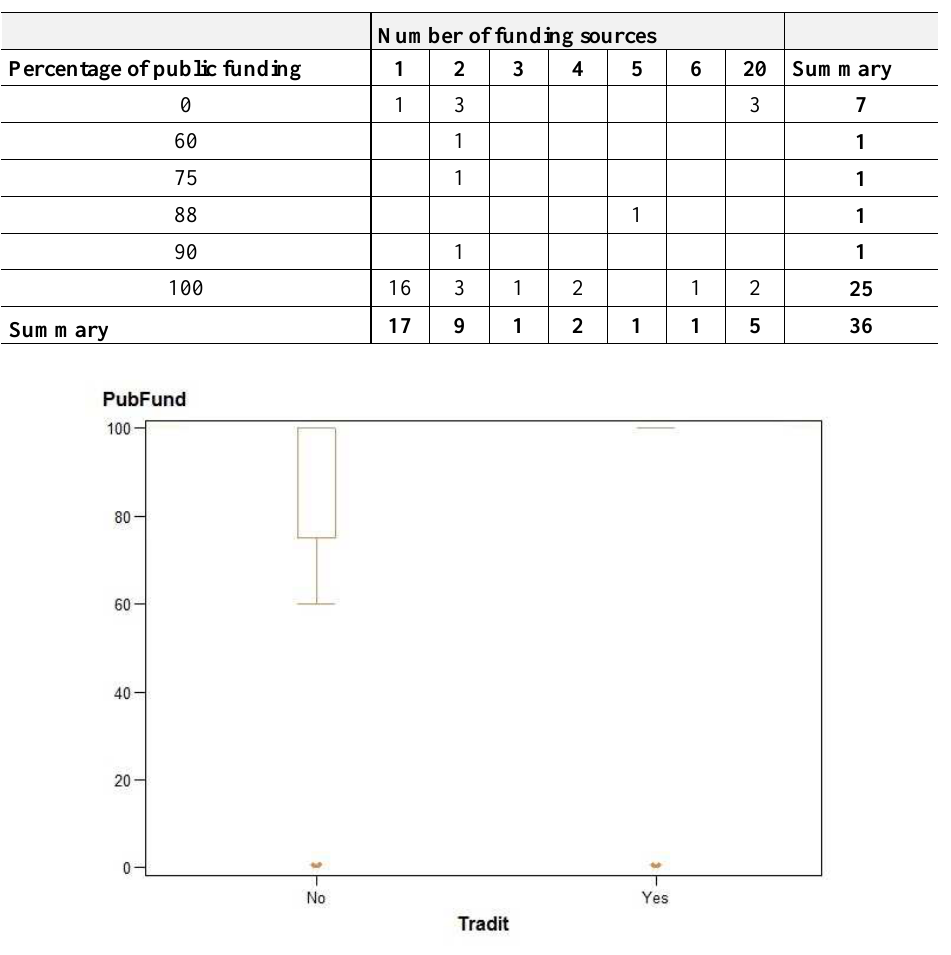
Figure 3 – Box-plot of percentage of public funding in Traditional and